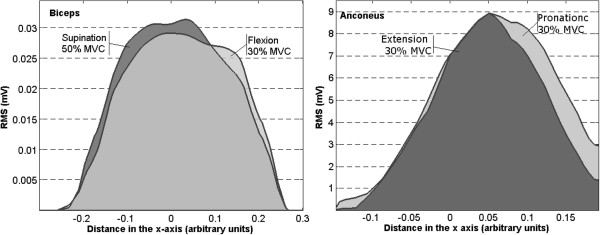
Projections Qkx for Biceps during Supination at 50% MVC and Flexion at 30% MVC (left) and Anconeus during extension at 30% MVC and Pronation at 30% MVC (right). Although the maximum and the area under each curve were similar for different exercises (p.n.s), their projection shifted laterally depending on the exercise kind.